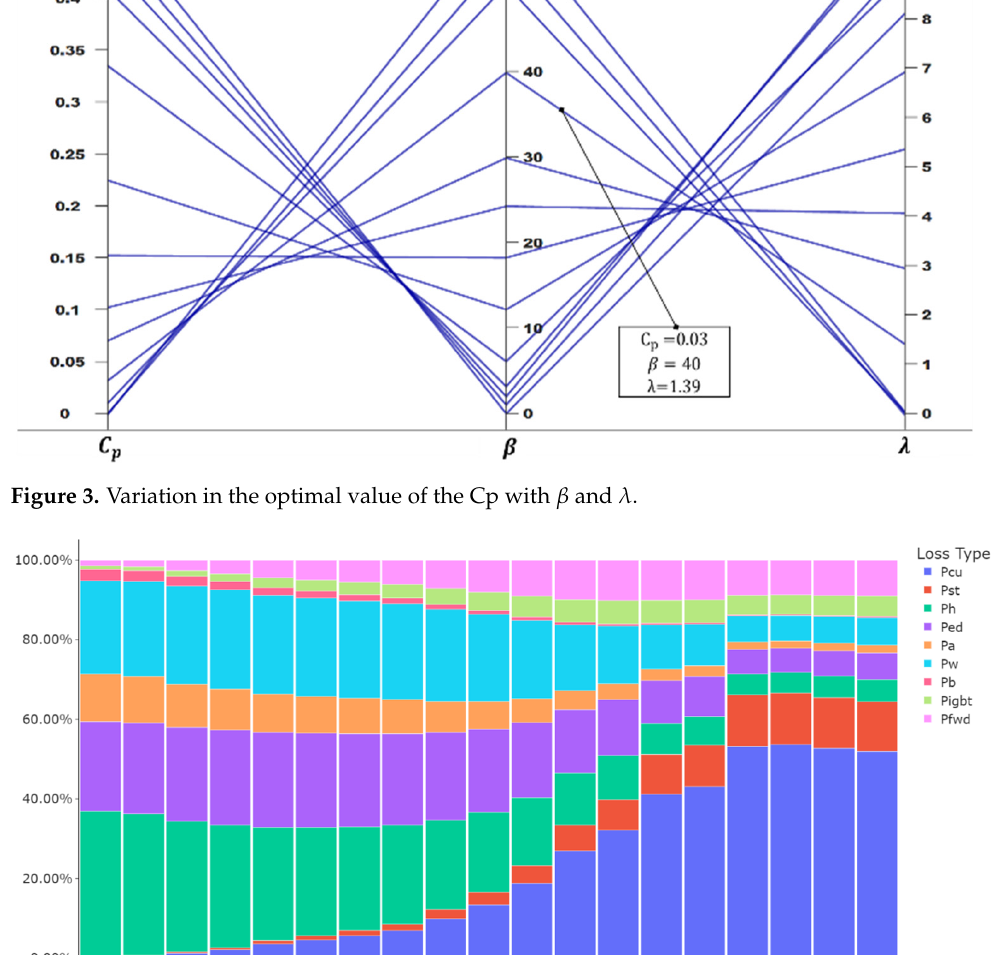
Figure 3. Variation in the optimal value of the Cp with β and 𝜆 .